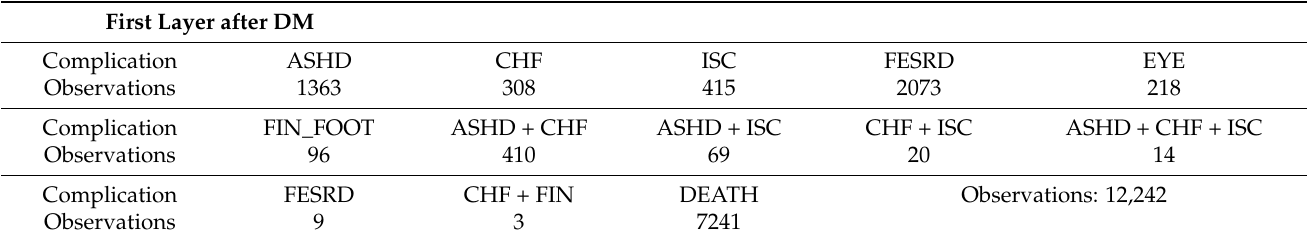
Table 5. Incidences of first layer complications or death in type 2 diabetes mellitus over 5 years.